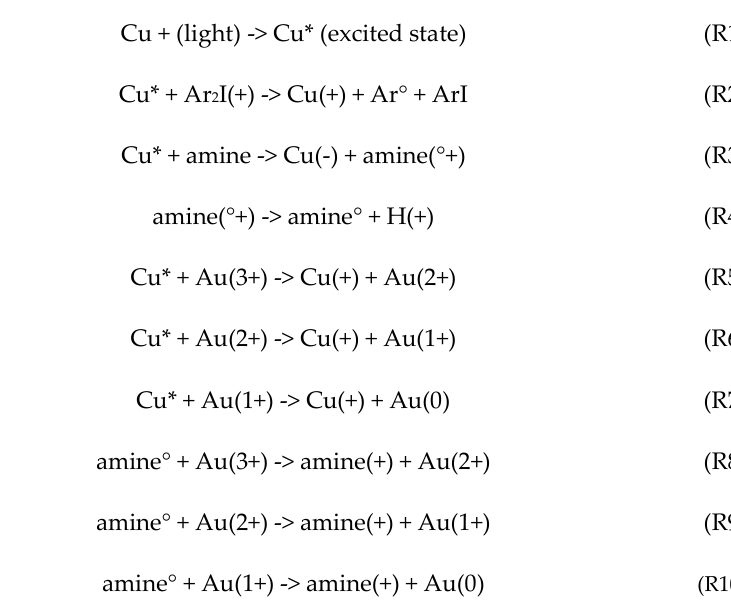
Scheme 1. A proposed kinetics for a 3-component system of G1/Iod/amine in gold chloride (HAuCl 4 ) solution, where G1 is the copper complex (HLCuCl), having an excited state Cu*, which couples with iodonium salt, Ar 2 I(+), and amine to produce radicals, (Ar 0 and amine 0 ) which lead to FRP. Both Cu* and amine 0 can couple with Au(3+) to form Au(2+), then Au(1+), leading to Au(0) and the